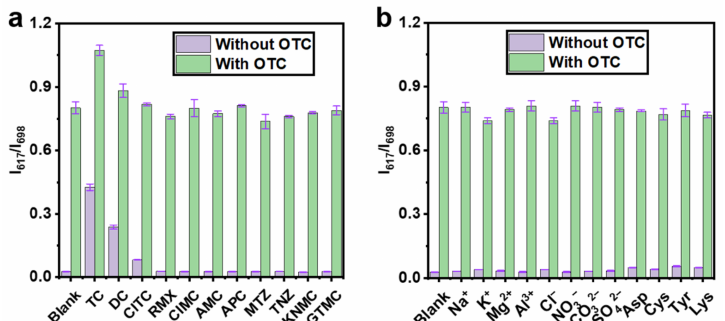
Figure 6. Selectivity and anti-interference ability of probe for OTC detection in the presence of other antibiotics ( a ), cations, anions, and amino acids ( b